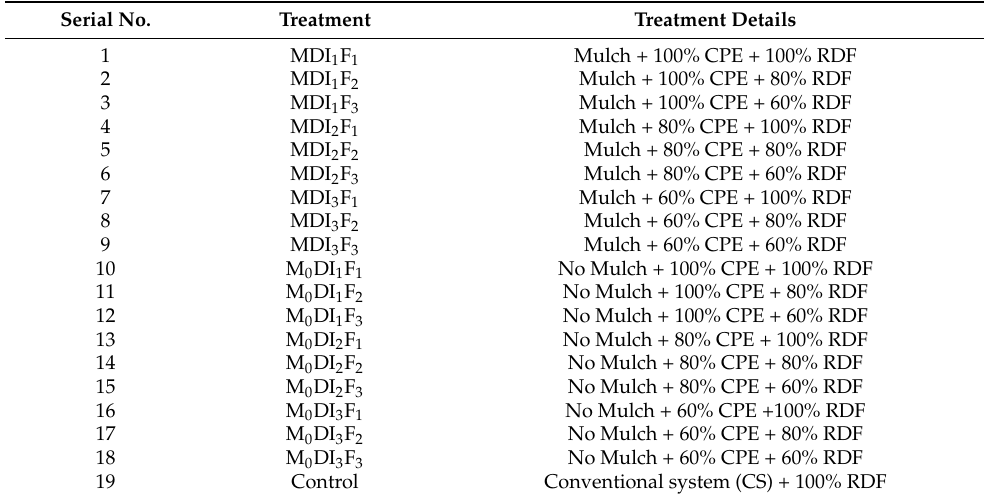
Table 1. Details of the treatment